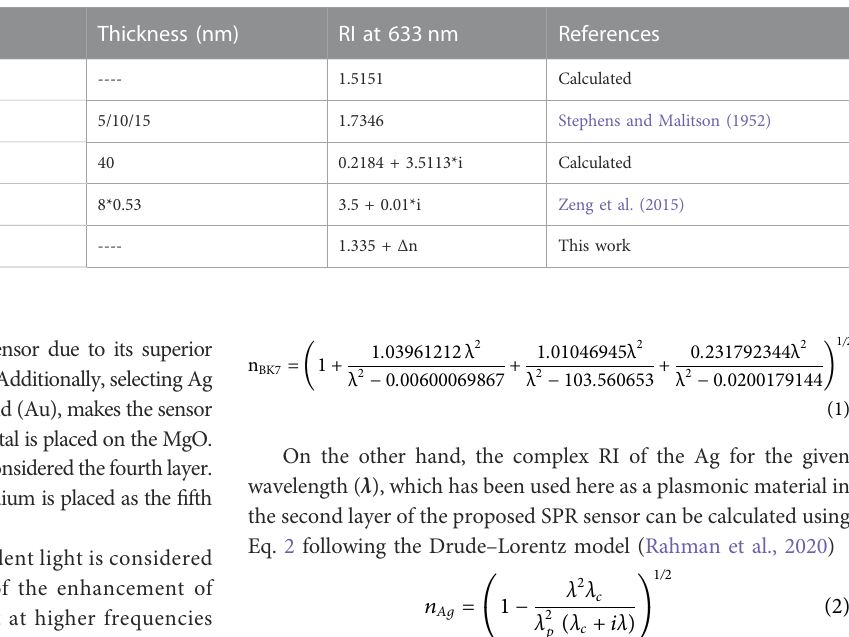
TABLE 1 Thickness and refractive index of various materials of the proposed sensor at wavelength 633